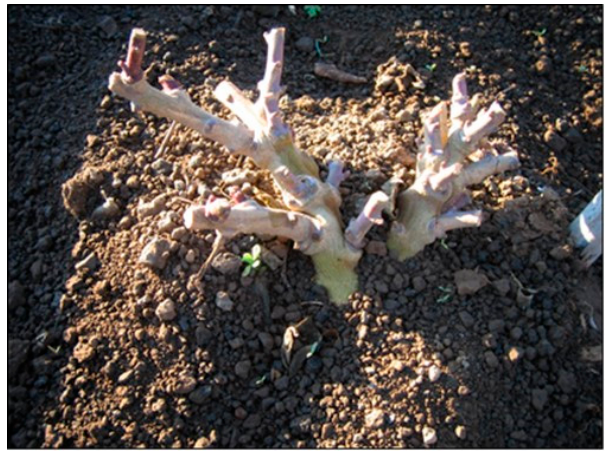
Figure 2. Pruning carried out in December 2007.